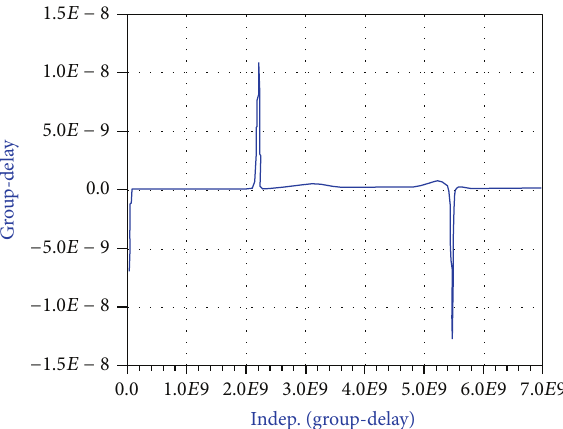
Figure 17: Frequency response of the simulated filter of reference in the workspace of ADS versus group-delay.